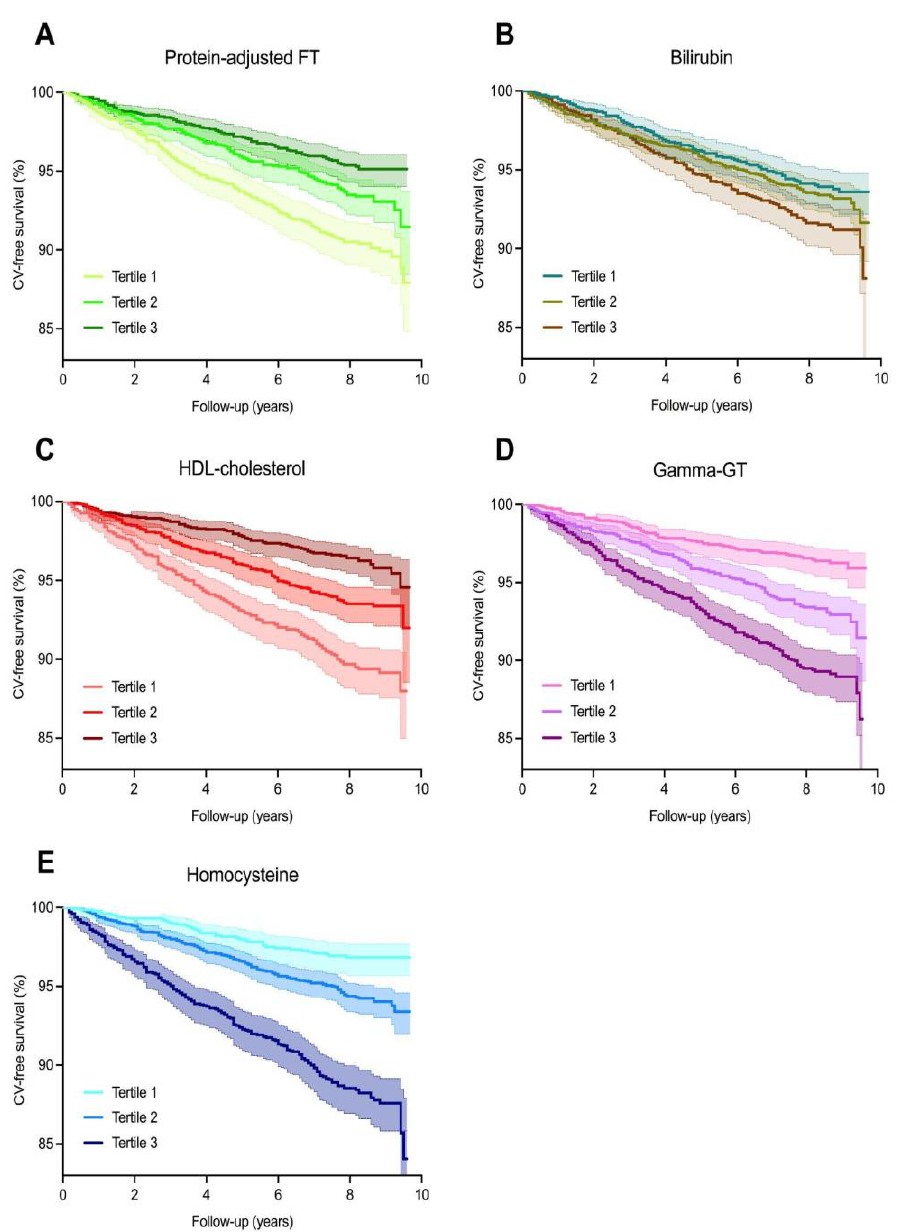
Figure 2. Kaplan–Meier survival distributions for tertiles of oxidative stress biomarkers. ( A – E ) Kaplan–Meier survival curves representing cardiovascular disease-free survival, with the highest rates of cardiovascular events occurring in the lowest tertiles of protein-adjusted FT (log-rank test, p < 0.001) and HDL cholesterol ( p < 0.001) levels, and the highest tertiles of gamma-GT ( p < 0.001) and homocysteine ( p < 0.001) levels.